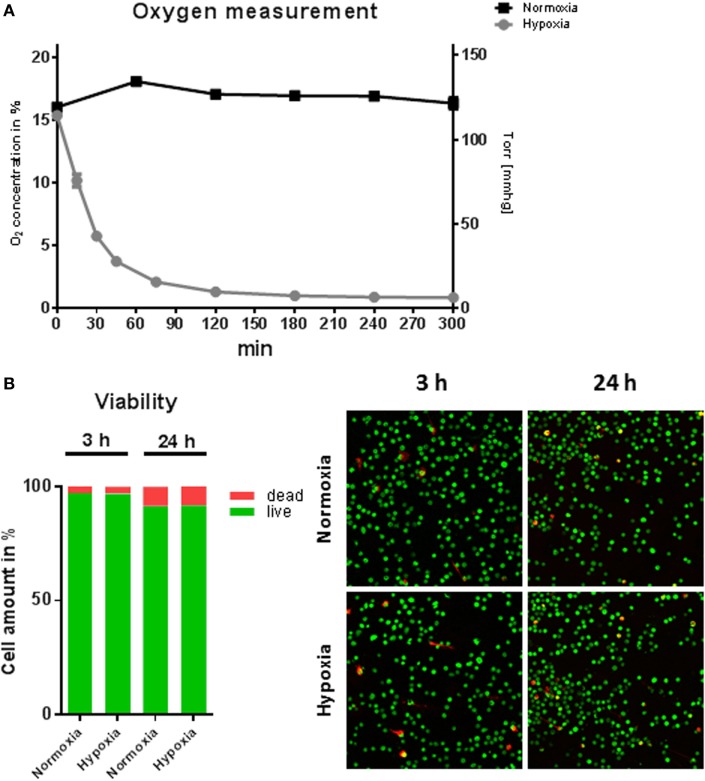
Oxygen concentrations and viability of mast cells (MCs) under hypoxia. (A) Oxygen concentrations in the media during culturing of MCs under hypoxia or normoxia. MCs were incubated for 5 h in normoxic and hypoxic environments. The dissolved oxygen concentration of the culture medium was measured using optical oxygen sensor spots (PreSens Precision Sensing GmbH) in intervals of 15 min to 1 h. Plotted values represent mean ± SEM of n = 3 experiments and are displayed as % oxygen on the left y-axis and mmHg oxygen on the right y-axis. (B) % viability of MCs (n = 6) after 3 and 24 h under hypoxia. Staining by a live/dead viability/cytotoxicity kit for mammalian cells (Invitrogen) indicates no differences in cell viability under hypoxia versus normoxia (red: dead cells; green: living cells).